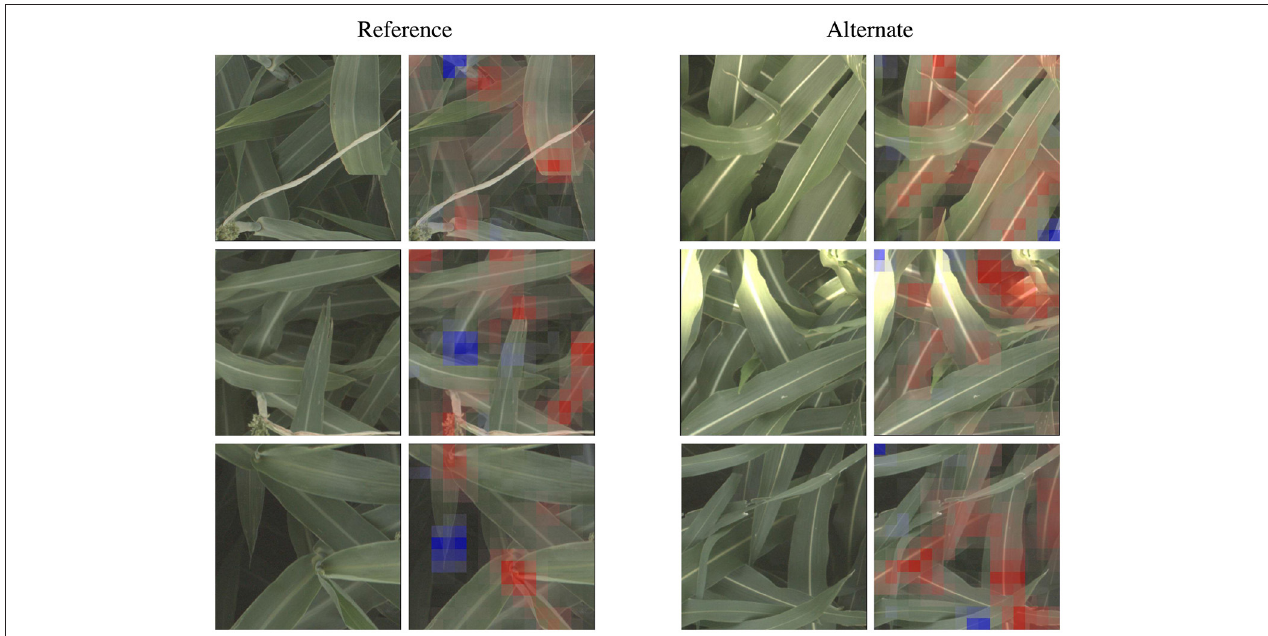
FIGURE 5 | The classification network trained on the leaf wax SNPs learned to focus on specific features for the reference and alternate class. When classifying an image as the higher wax content “reference” class, the network often focuses on the interface between the stem and either leaves or panicles, where the wax build up is most high. When classifying an image as “alternate”, the network instead often focuses on the vivid mid-vein of the leaf that is more obvious when leaf wax content is lower. These features correspond to phenotypes that field biologists observe in the field. Features highlighted in red are those that led the network to make its correct classification, while features in blue are those which detracted from the correct